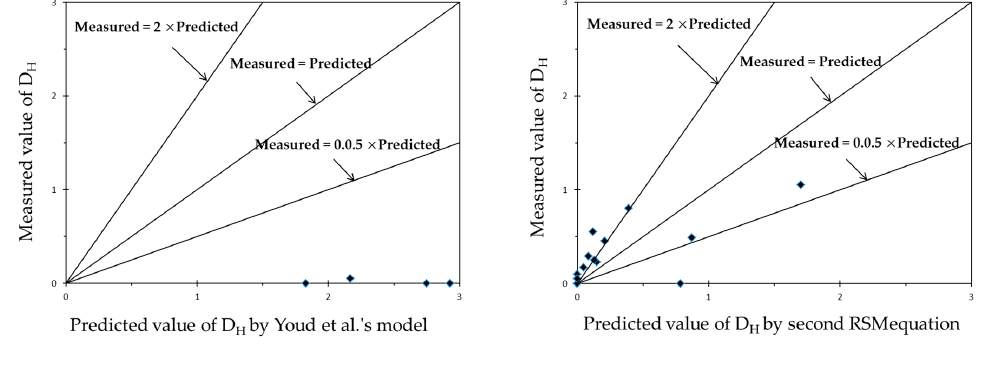
Figure 6. Comparison between the first RSM equation and three extra models with 28 data points measured from sites of Chi-Chi earthquake.